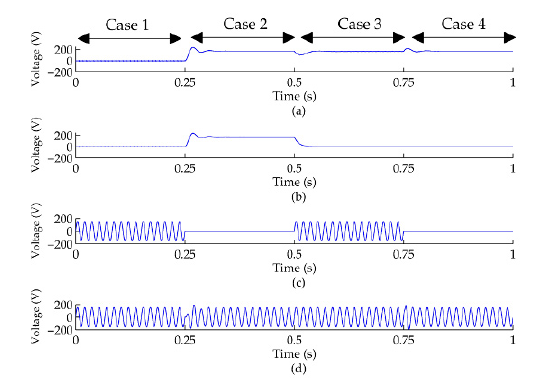
Figure 9. Output from Simulink including Case 1 to Case 4. (a) (b) Output of Boost Converters. (c) Output from the grid. (d)